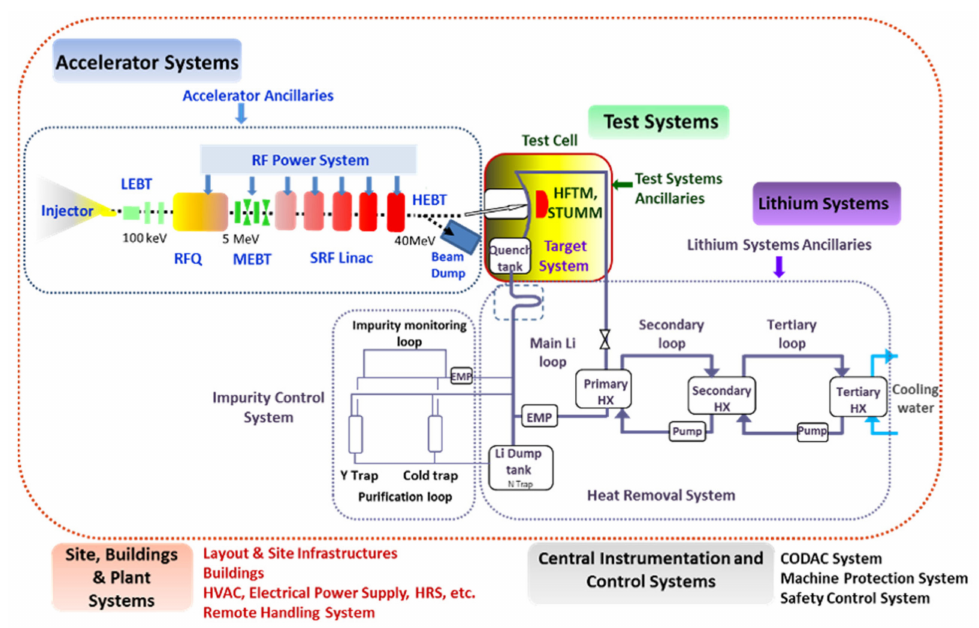
Figure 1. IFMIF-DONES plant system configuration.